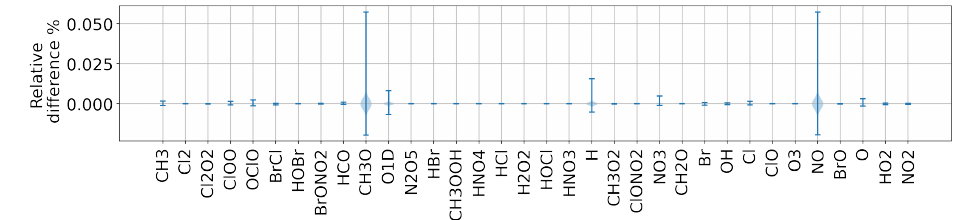
Figure 3. Relative difference of species concentrations for the strato model with Ros4 solver for RelTol = 10 − 3 comparing the double-precision and the new mixed-precision implementation of